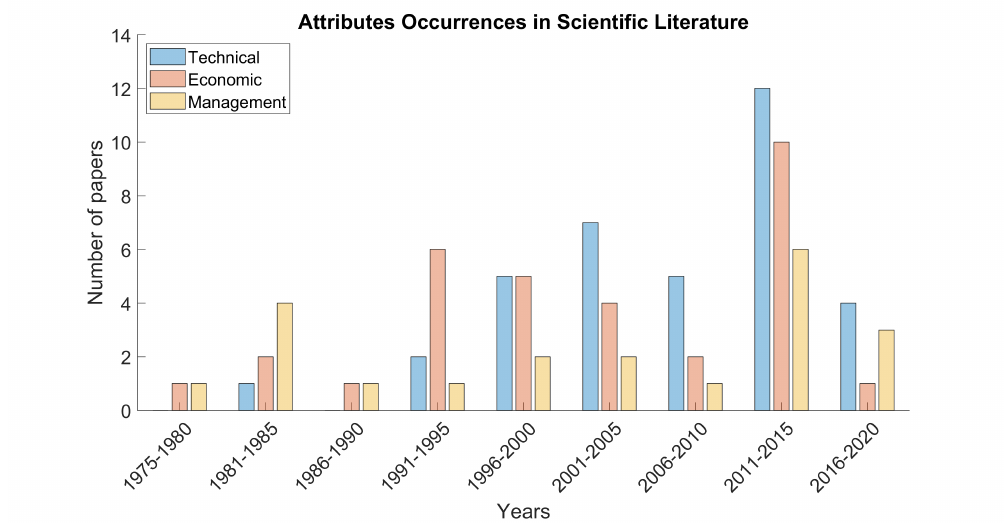
Figure 1. Evolution in time of the number of attributes evaluated in RSP literature, arranged by categorical areas. Data are aggregated in 5-year subsets.